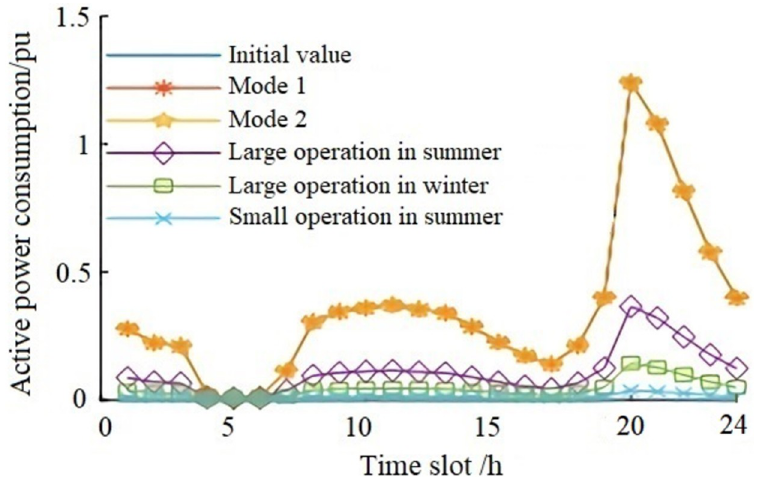
Fig 4. Trend diagram of active power loss in the